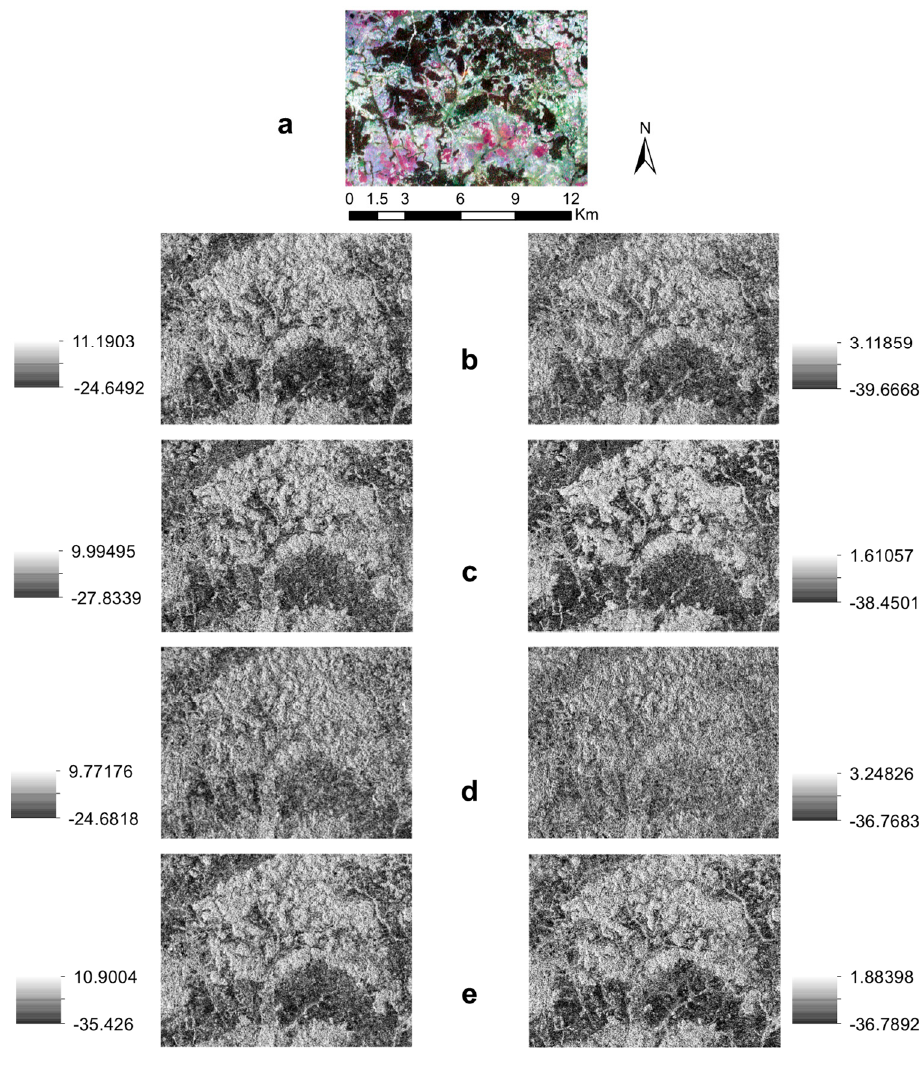
Figure 4. Radar backscatter intensity (dB) of selected 4, of the analyzed 10, images of the study landscape to illustrate the seasonal intensity from 2015 to 2017: ( a ) a RapidEye natural color composite image (RGB: bands 1, 2, and 3; ( b ) the start of the wet season, 17 August 2015; ( c ) the peak of the dry season, 20 March 2016; ( d ) the peak of the wet season, 4 September 2016; and ( e ) the middle of the dry season, 14 January 2017. The left and right columns are the VV and VH backscatter for each image, respectively. The north bar and the scale bar are applicable to all images.